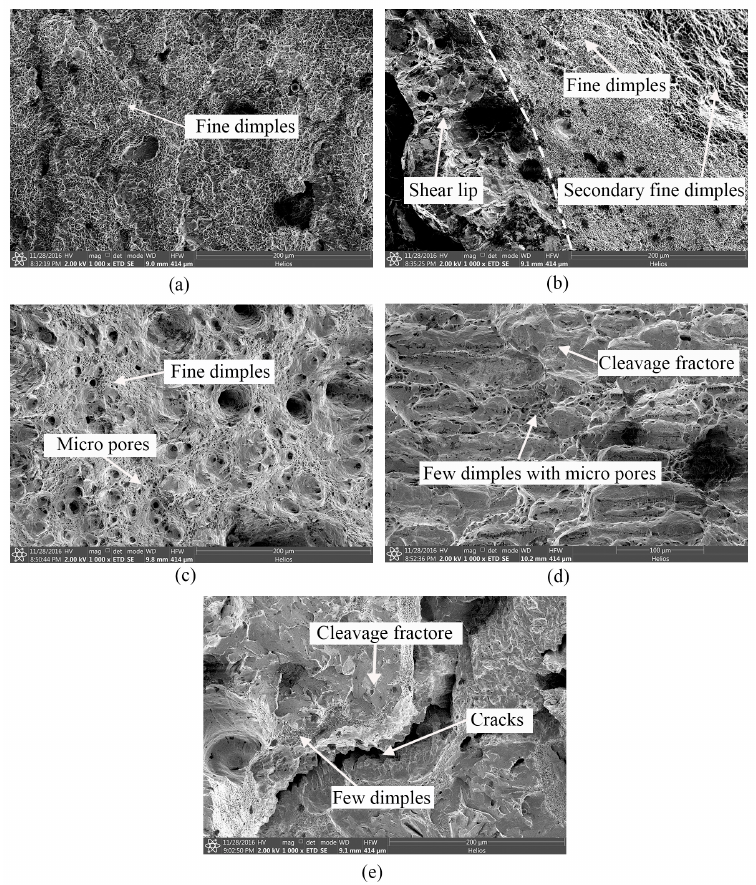
Figure 12. SEM fractographs of impact specimens with different welding speed ( a ) 0.4 m/min; ( b ) 0.6 m/min; ( c ) 0.8 m/min; ( d ) 1.0 m/min; ( e ) 1.2 m/min.